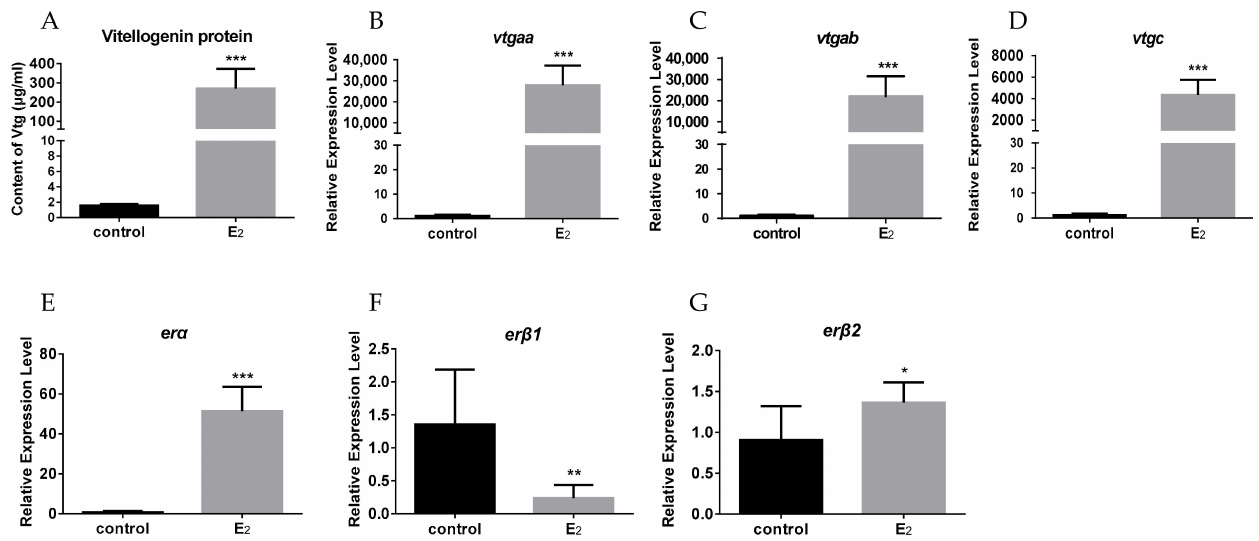
Figure 2. The content of VTG protein and mRNA expression of vtgs and ers in the livers of juvenile female groupers in injection group ( n = 8) (5mg/kg E 2 ) and control group ( n = 8): ( A ) VTG protein levels in the liver; ( B – G ) the mRNA levels of vtgaa , vtgab , vtgc , er α , er β 1 , and er β 2 in the liver. Data are expressed as the mean ± SEM ( n = 8) and analyzed by unpaired Student’s t -test. Asterisks (*) indicate statistical differences (* p < 0.05, ** p < 0.01, *** p < 0.001). Moreover, a primary hepatocyte culture system was established using the livers of the juvenile females, and the cells were incubated with different concentrations of E 2 (from 0 to 1 µ M) for 24 h. The results showed that E 2 treatment significantly stimulated the protein and mRNA expression of vtgs in a dose-dependent manner (Figure 3A–D), and evoked the dose-dependent expression of er α and er β 2 in the hepatocytes (Figure 3E,G). However, a dose-dependent decrease in er β 1 expression was observed with increasing concentrations of E 2 treatment (Figure 3F).